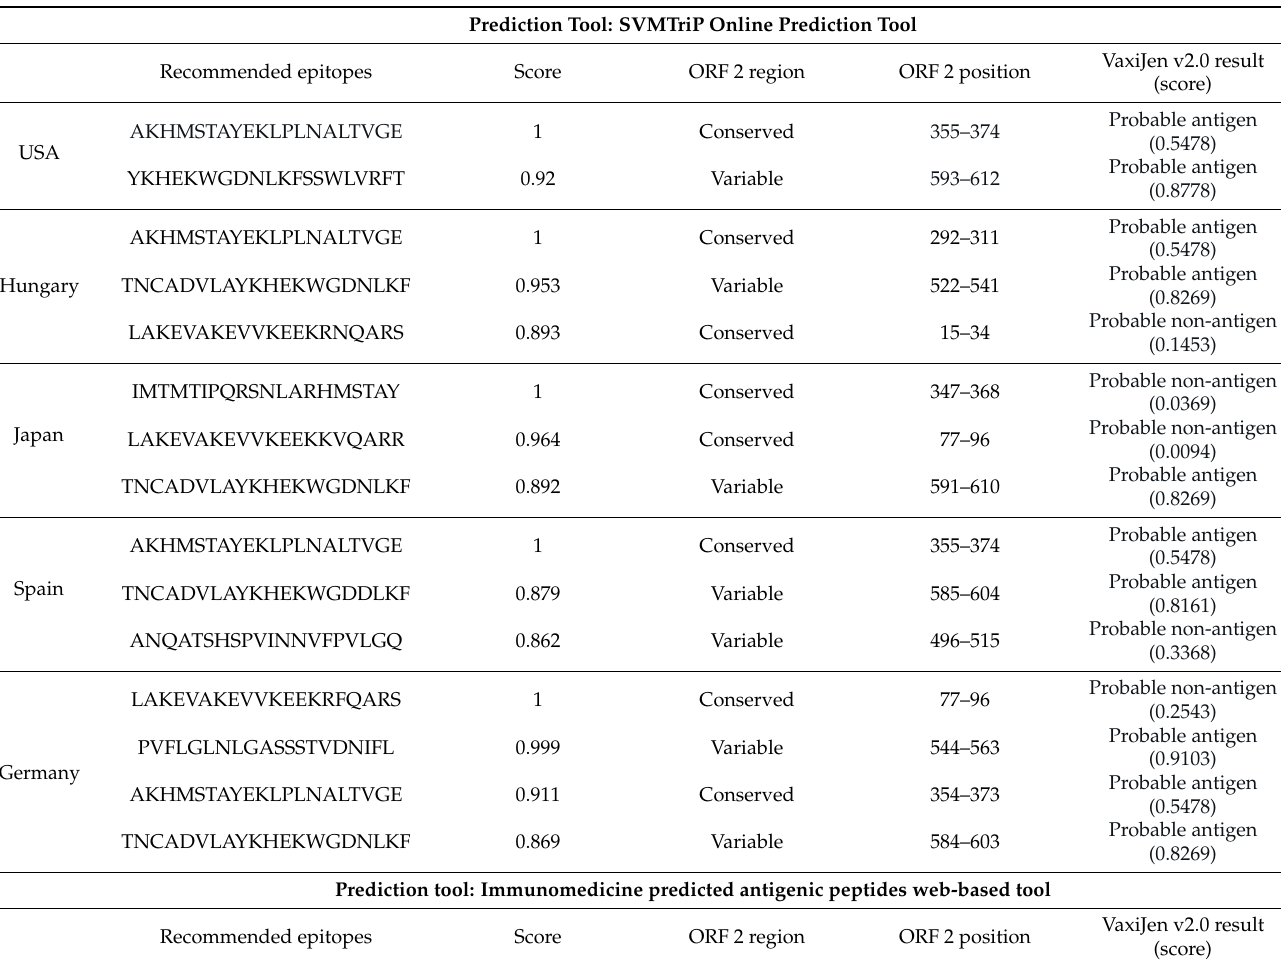
Table 3. Linear epitope and antigen prediction results. Prediction Tool: SVMTriP Online Prediction